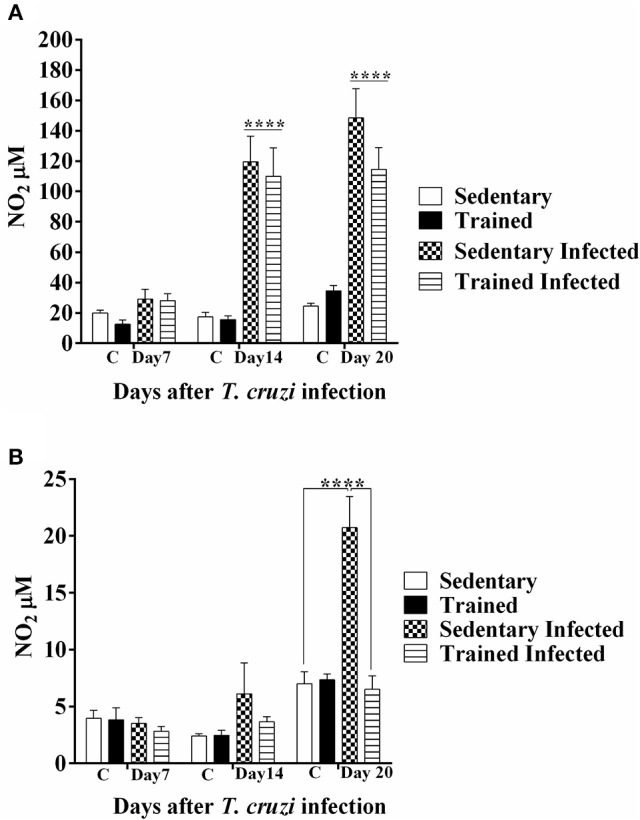
Treadmill exercise modulates nitric oxide (NO) production. Sedentary and trained mice infected or not with T. cruzi were bled at 7, 14, and 20 days post-infection (DPI) for NO measurements. NO was estimated by measuring nitrite levels via the cadmium–copper system followed by Griess reaction, as described in material and methods. (A) Levels of NO in the plasma. ****P < 0.0001 comparing infected mice (14 and 20 DPI) with infected (7 DPI) and non-infected age matched control mice, five mice per group. (B) Levels of NO in the heart. P < 0.0001 comparing sedentary infected with sedentary uninfected and trained infected mice.